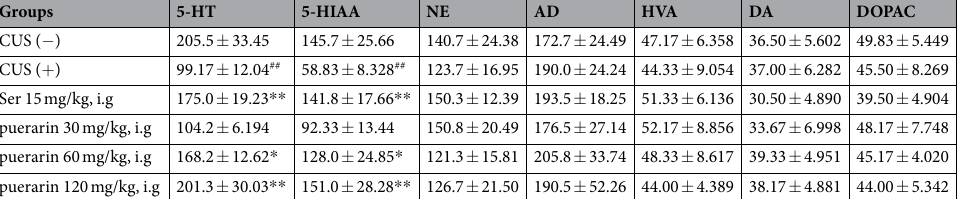
Table 3. The effects of puerarin on hippocampal monoamine neurotransmitter levels in CUS rats. ## p < 0.01 vs.